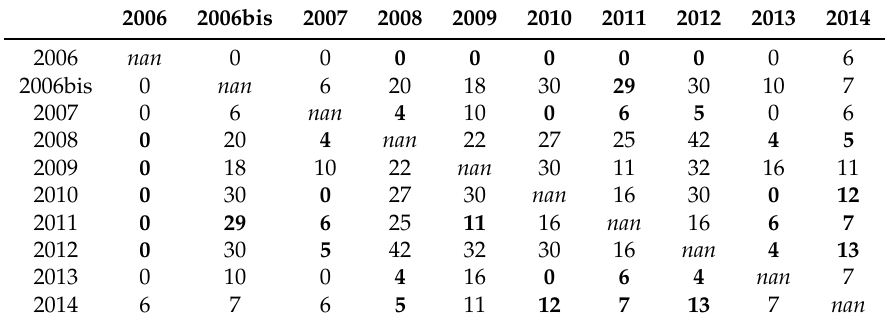
Table A2. Wilcoxon signed-rank test significance table for LOO-CV computed from the overall accuracy of the 50 predictions for each single-year SITS. In bold , where p < 0.05.